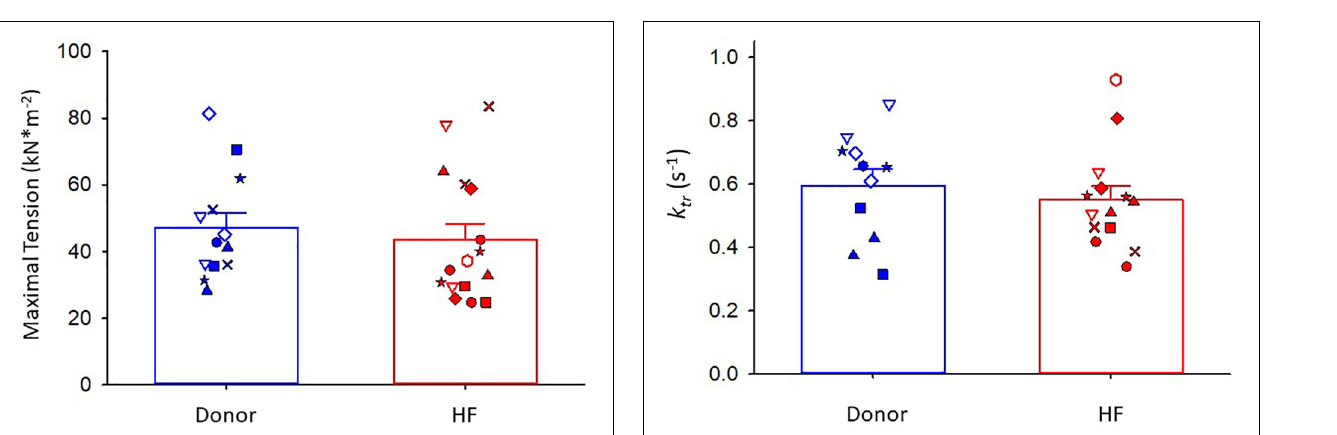
Ca 2 + -activated tension was 0.902 ± 0.037 of the initial pCa 4.5